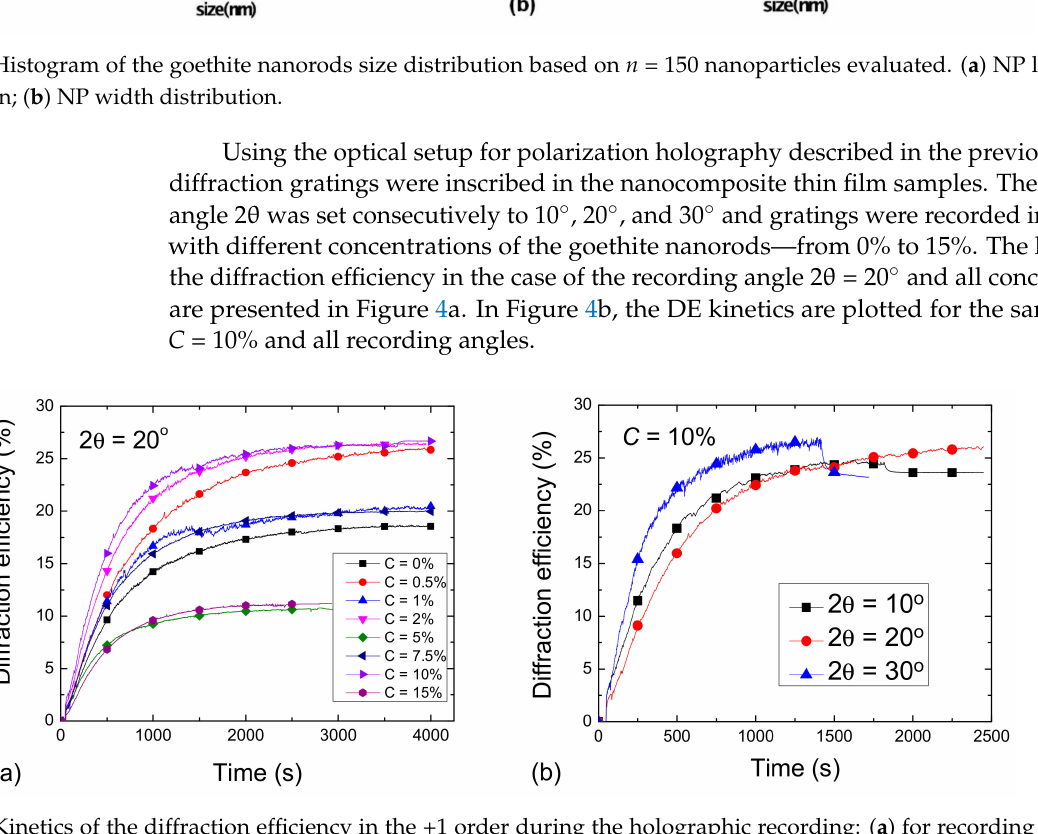
Figure 4. Kinetics of the diffraction efficiency in the +1 order during the holographic recording: ( a ) for recording angle 2 θ = 20 ◦ and all samples with C = 0–15%, ( b ) for concentration of the goethite nanorods C = 10% and recording angles 2 θ = 10 ◦ , 20 ◦ , and 30 ◦ (symbols are plotted in ( a ) at every 500 and in ( b ) at every 250 data points to distinguish the